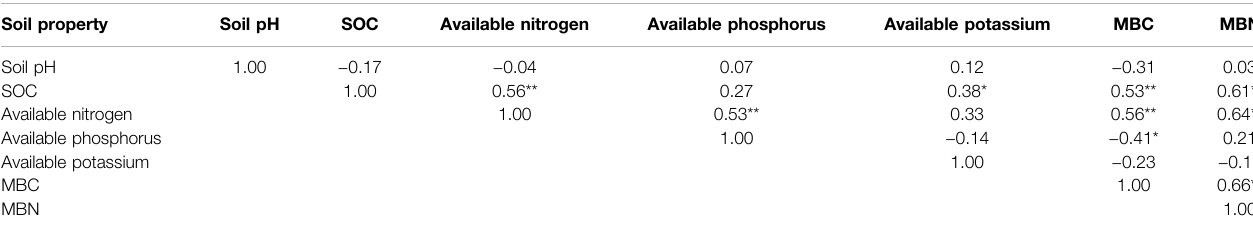
TABLE 4 | Interrelationships (Pearson ’ s correlation coef fi cient “ r ” ) among properties of all land use systems. Soil